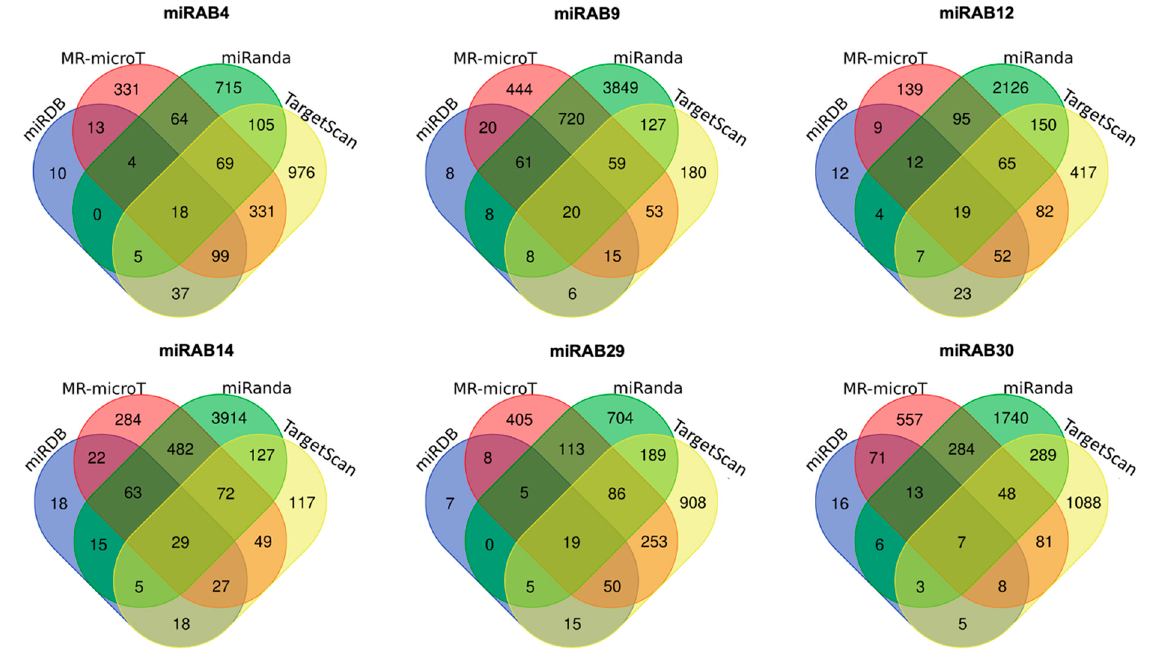
Figure 3. Target prediction analysis. Target mRNAs for each miRAB4, miRAB9, miRAB12, miRAB14, miRAB29, and miRAB30 were performed using miRDB, MR-microT, miRanda, and Target Scan programs. Cut off criteria for each tool were score > 80 for miRDB, score > = 0.7 for MR-microT, max E < = − 20 for miRanda, and context ++ < − 0.3 for TargetScan. To identify commonly predicted target genes, the Venn diagram analysis was performed.